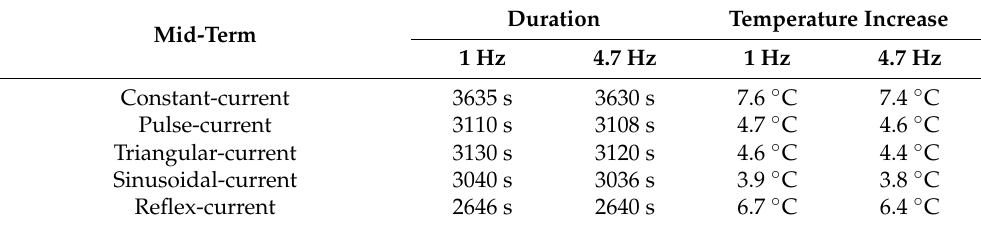
Table 4. Experiment results of five charging